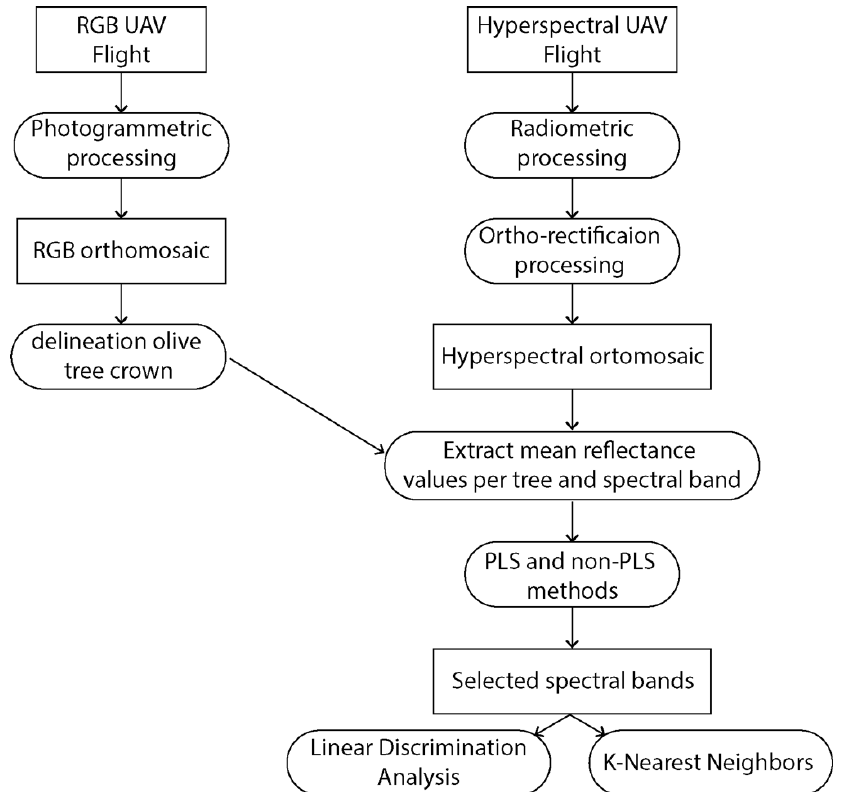
Figure 1. Flowchart used for the classification of irrigation techniques.